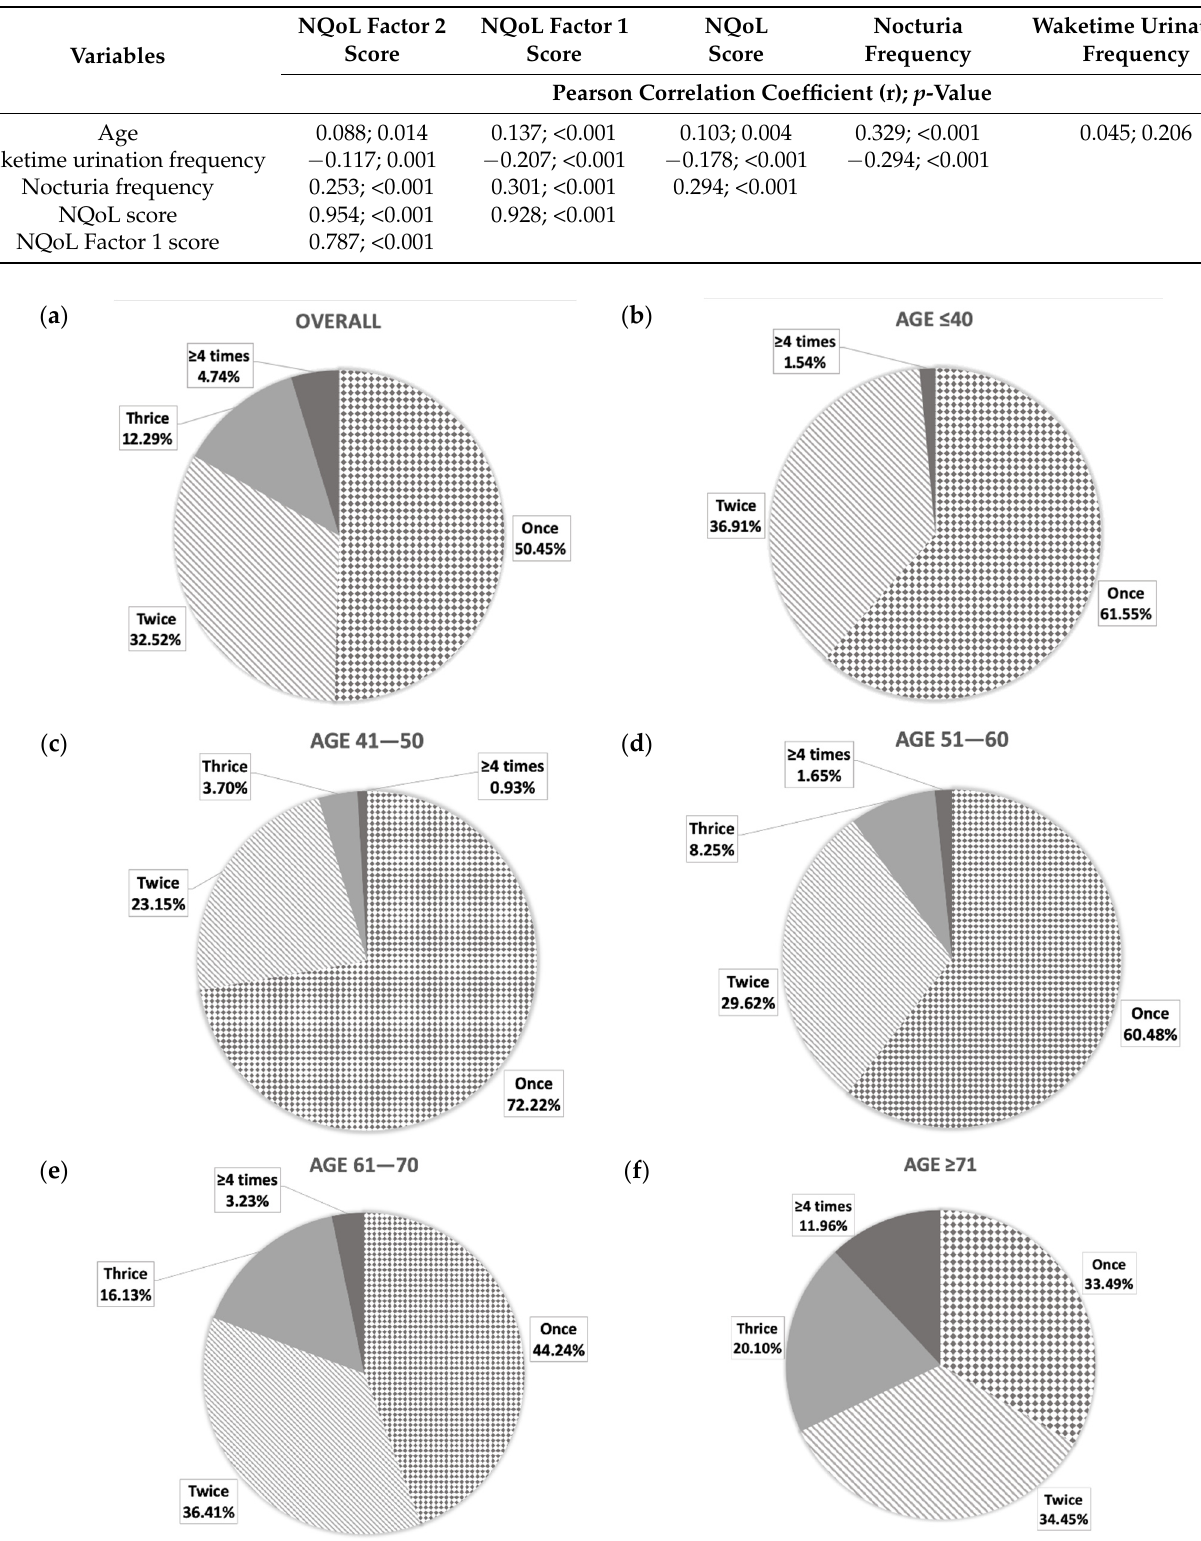
Figure 2. Distribution of nocturia episodes in: ( a ) the overall studied nocturia population, which was divided into different age groups at: ( b ) 18–40 years; ( c ) 41–50 years; ( d ) 51–60 years; ( e ) 61–70 years; and ( f ) ≥ 71 years.